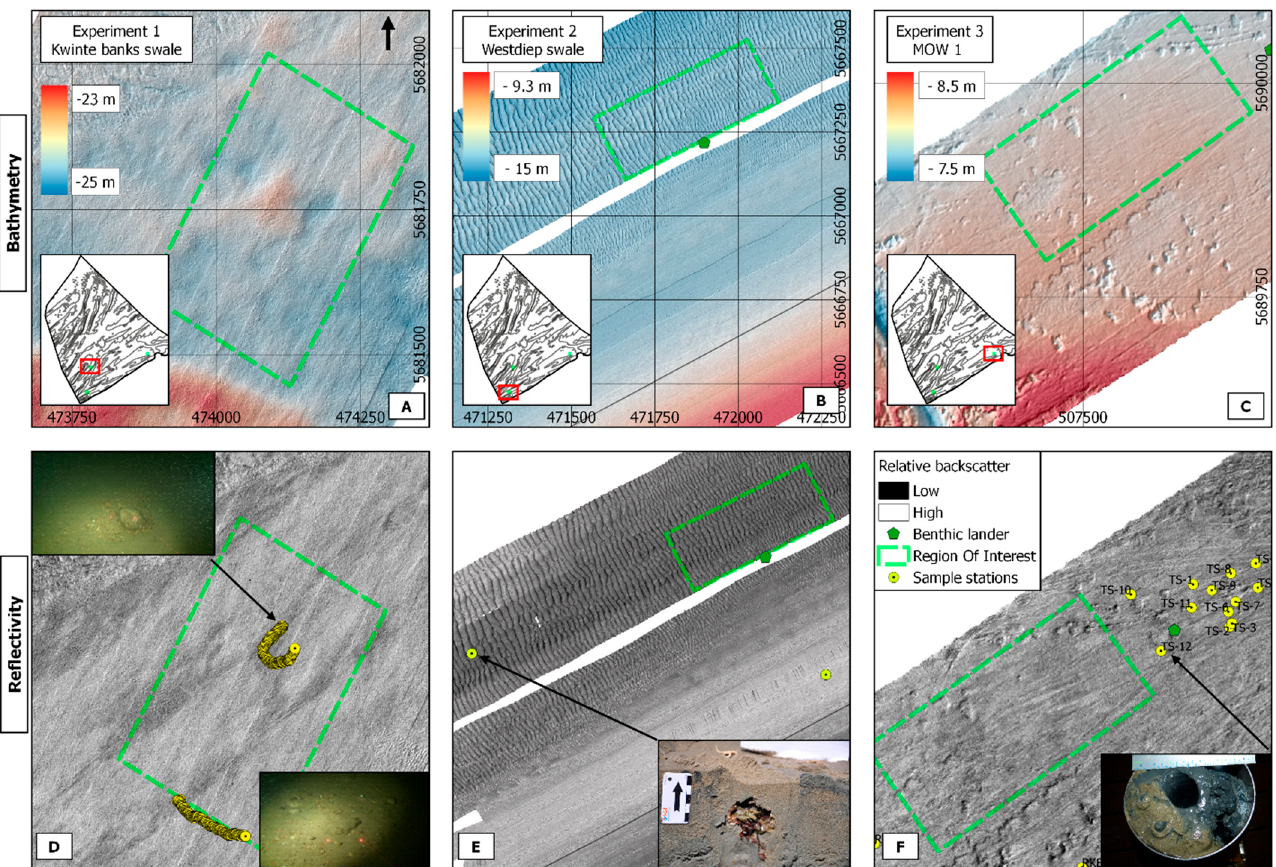
Figure 5. Details of the bathymetry ( A – C ) and reflectivity maps ( D – F ) for each study area. For experiments II ( B – E ) and III ( C – F ), the location of the benthic lander, equipped with various oceanographic sensors, is denoted by a dark-green pentagon. Ground-truth stations are denoted by yellow circles, whereas the ROIs are denoted by green dashed-line polygons. Photographic details of the substrate types are also shown: for the Kwinte swale area images ( D ), the laser points are 9 cm apart (Courtesy of A. Norro, Royal Belgian Institute of Natural Sciences). Severe modification of the seabed by bottom trawling gears is noticeable at the MOW 1 study site ( C , F ): patterns of substrate erosion (elliptical depressions of ~10 to 30 cm in depth and up to 15 m in diameter) occur in the immediate proximity of the trawl marks.